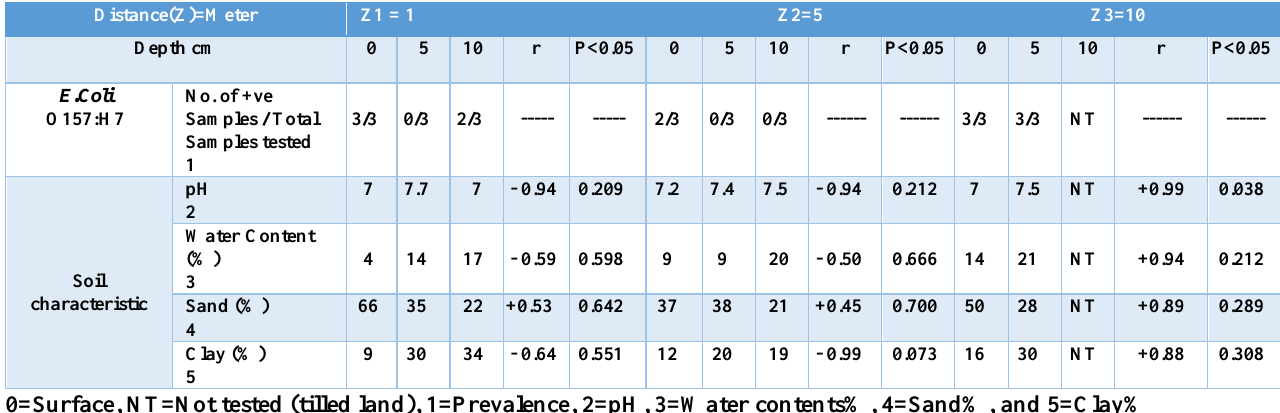
Table, 6: Correlation (r) between the prevalence of E.Coli O157:H7 and physico-chemical characteristics of the soil at the left (L) side of the dairy farm.